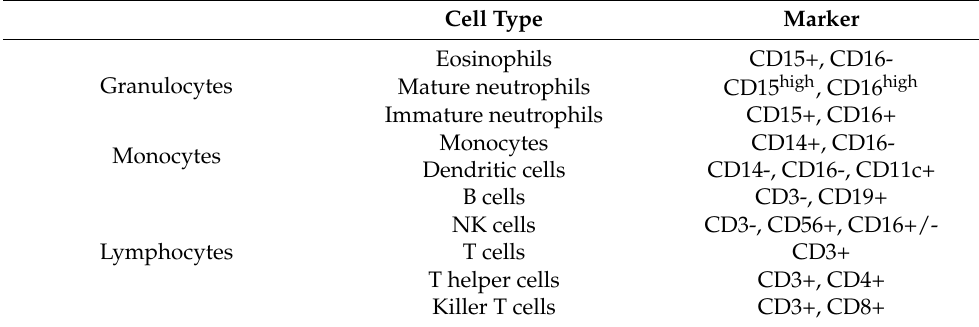
Table 1. Markers Used in Flow Cytometry to Identify Immune Cells in Peripheral Blood.